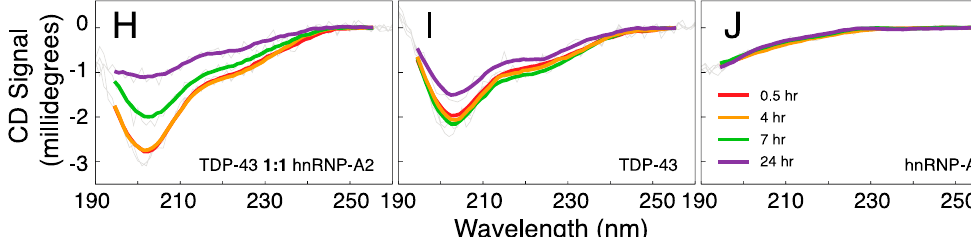
Figure 3. The time evolution of NMR HSQC and circular dichroism spectra indicates that conformational change in TDP-43 266–414 is accelerated by the presence of hnRNP-A2 288–341 . ( A – C ) Time sequences of NMR HSQC spectra of 15 N-TDP-43 ( A ) in the presence and ( C ) in the absence of hnRNP-A2 288–341 , and ( B ) of 15 N hnRNP-A2 288–341 in the presence of TDP-43 266–414 . Assignments are shown for the cross-peaks whose position or intensity clearly change over time. ( D – F ) Time sequences of NMR peak intensity profiles as a function of residue number for ( D ) TDP-43 266–414 mixed with hnRNP-A2 288–341 and ( E,F ) for TDP-43 266–414 alone. ( G ) Primary sequence of TDP-43 266–414 with residues highlighted in black if the corresponding NMR intensity decreases over time. The α -helical and Q/N rich regions are also indicated. ( H – J ) Circular dichroism spectra at different incubation times of ( H ) the mixture sample, ( I ) TDP-43 266–414 alone and ( J ) hnRNP-A2 288–341 only.